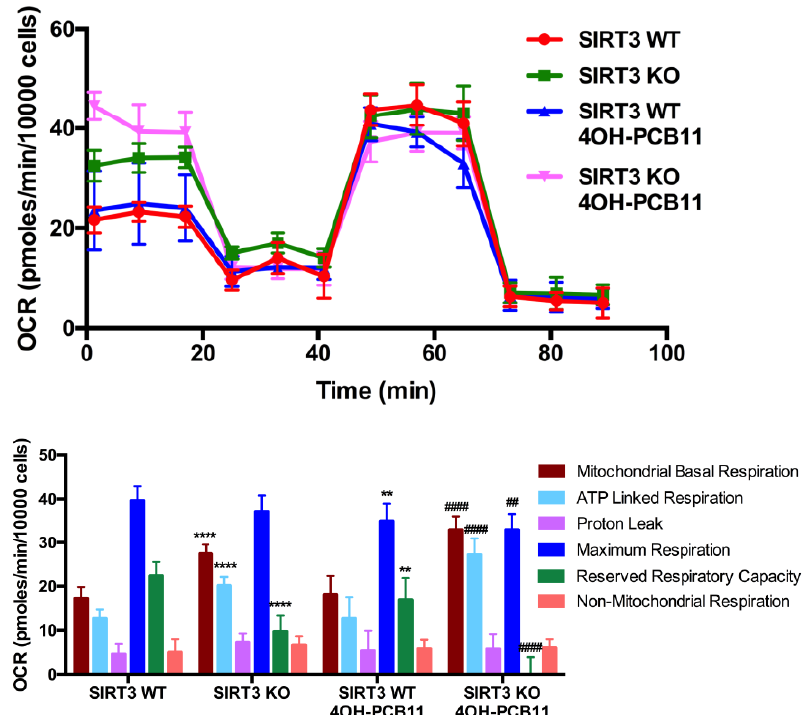
Figure 4. Basal and ATP-linked respiration increased in SIRT3-KO MEFs, and reserve respiratory capacity decreased. WT and SIRT3-KO MEFs were trypsinized and plated in Seahorse XF96 cell culture plates. The next day, cells were treated with 3 µ M 4OH-PCB11 or vehicle for an additional 24 h. Cells were washed in buffered DMEM and then changed to assay medium. The oxygen consumption rate (OCR) was measured with sequential injections of oligomycin, FCCP, and antimycin A-rotenone mixture (upper panel). The OCR was calculated and plotted for basal, ATP-linked, proton leak, reserved respiratory, and non-mitochondrial respiration. Data shown are representative of three independent experiments. Data are the mean ± 1SEM ( n = 18–22). ** p < 0.01; **** p < 0.0001 as compared to vehicle-treated WT control group. ## p < 0.01 and #### p < 0.0001 as compared to vehicle-treated SIRT3-KO control